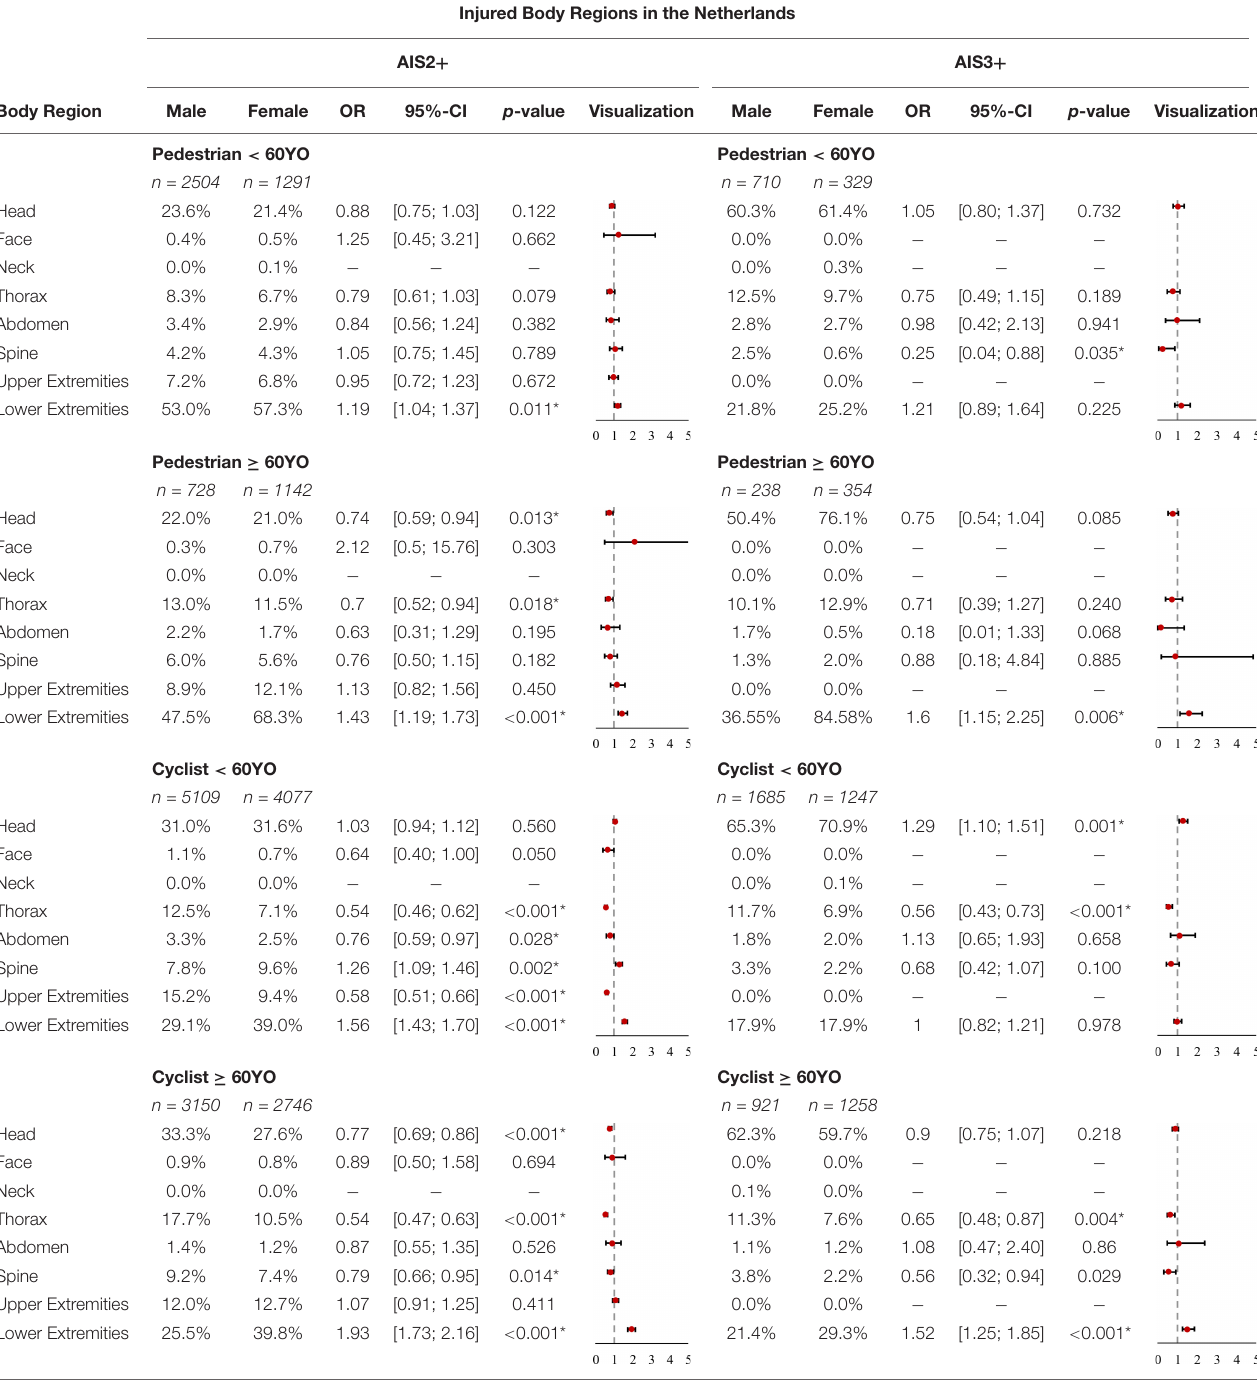
TABLE 5 | Share of injured body regions for AIS2 + and AIS3 + injuries, OR and p -value in the Netherlands for pedestrians and cyclists < 60YO and ≥ 60YO (* p -value < 5%). Injured Body Regions in the